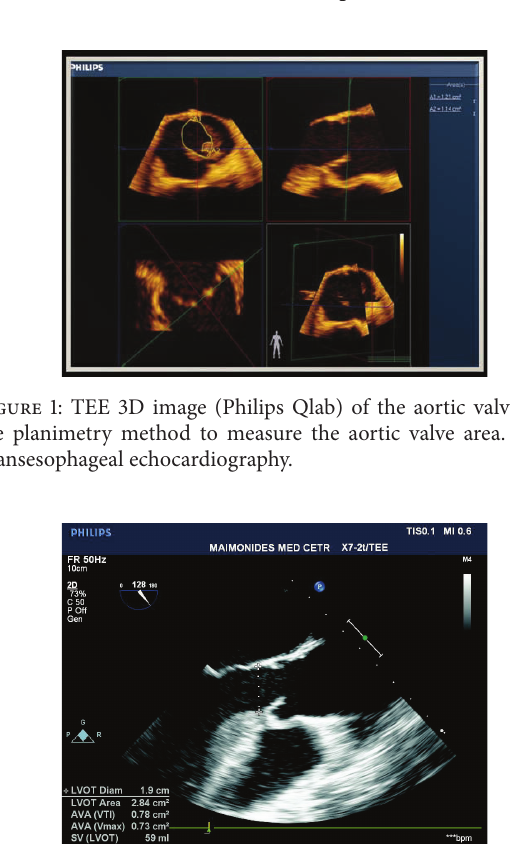
Figure 2: TEE image of the midesophageal aortic valve long axis (ME AV LAX) view measuring the LVOT diameter (one of three measurements used to calculate the aortic valve area using the continuity equation). LVOT = left ventricular outflow